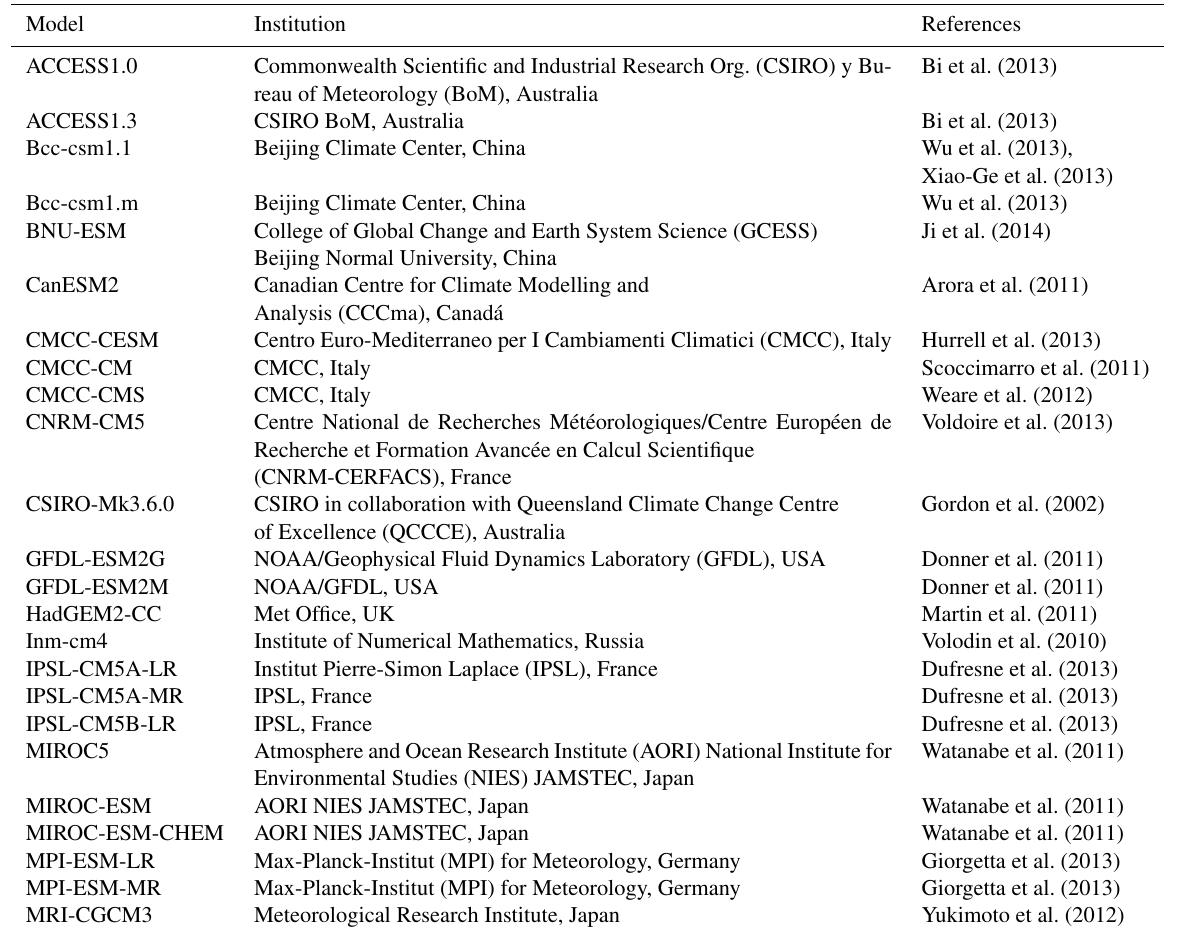
Table 3. List of CMIP5 models used in the 3rd delivery of Regionalized Projections by AEMET. Model